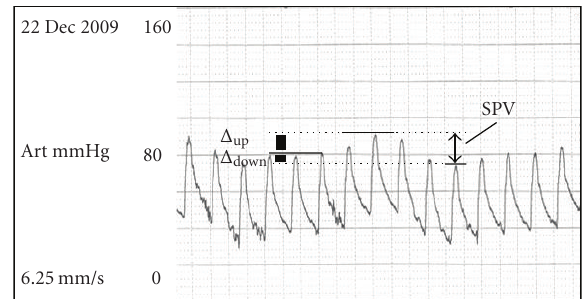
Figure 2: Arterial line tracings showing systolic pressure variation during the respiratory cycle. The pressure at end expiration defines baseline systolic pressure. SPV has two components, delta up and delta down, corresponding to systolic pressure waves reading at peak amplitude of early inspiration (the upward component or delta up) and at end inspiration (the downward component or delta down). The total amplitude variation or the sum of delta up and delta down is thus the SPV, shown with the arrow on the right of the